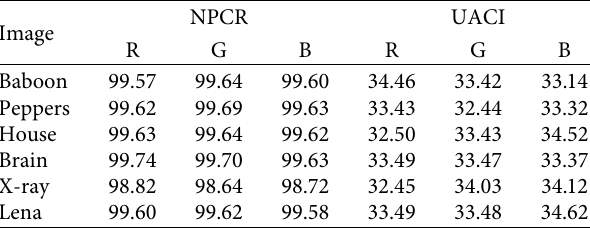
Table 6: NPCR and UACI measures for standard images.